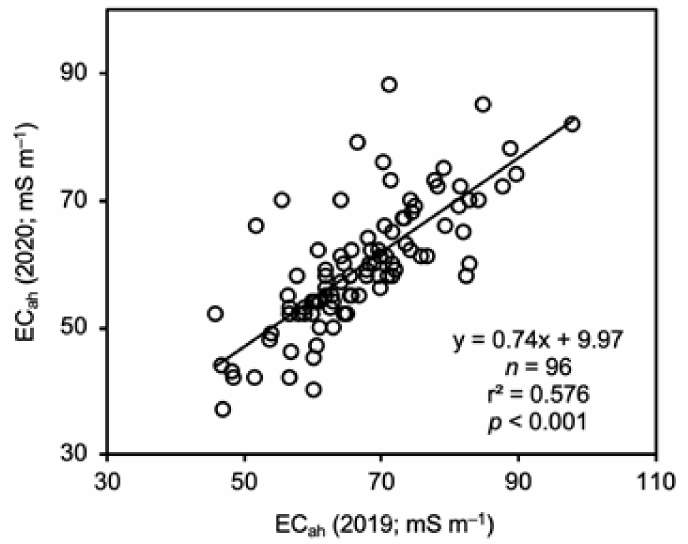
Figure 7. Correlations of EM38 readings in the horizontal orientation (EC ah values) collected on 10 October 2019 and, at the same plot locations, on 21 September 2020. The soil was a Vertic Calcic Calcisol located on Merredin Research Station ( − 31 ◦ 30 (cid:48) 25 (cid:48)(cid:48) S, 118 ◦ 13 (cid:48) 04 (cid:48)(cid:48)